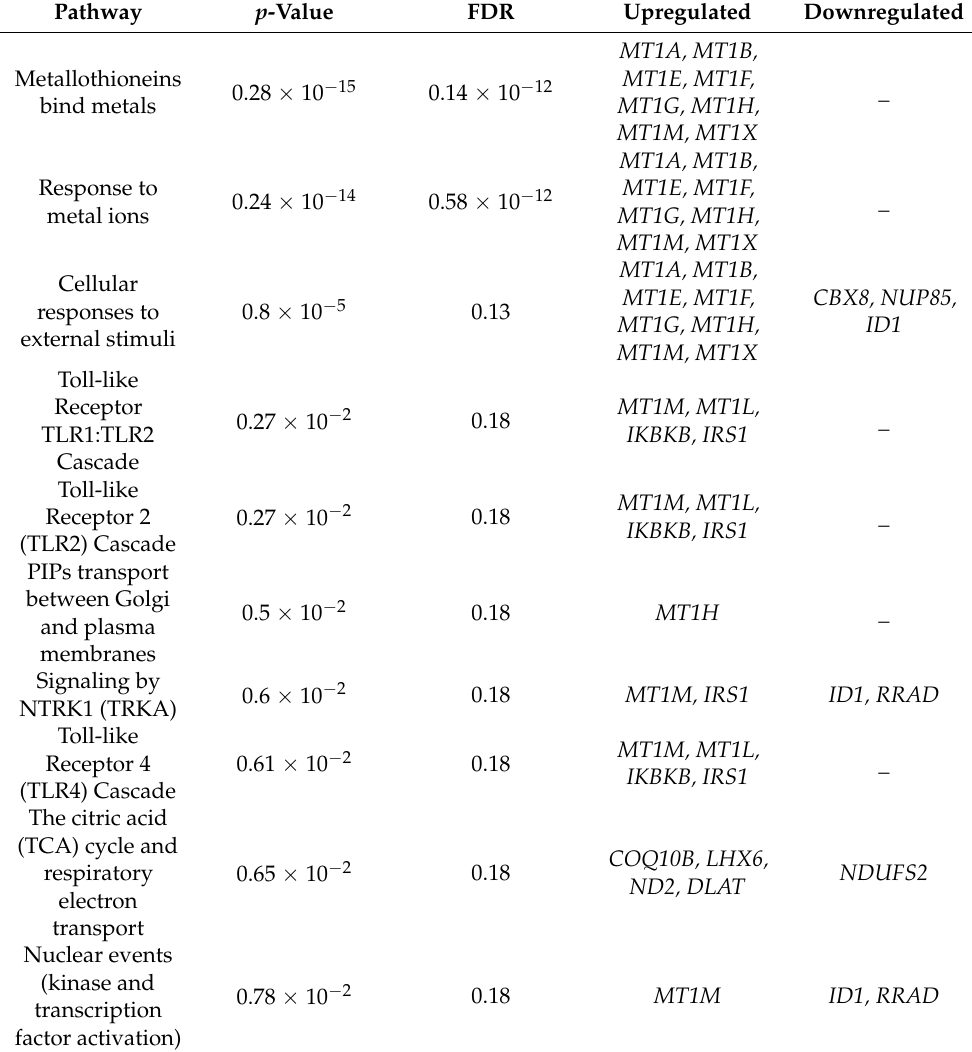
Table 1. Top 10 pathways enriched by 58 DEGs common to treatments by polymyxin B, FADDI-251 and